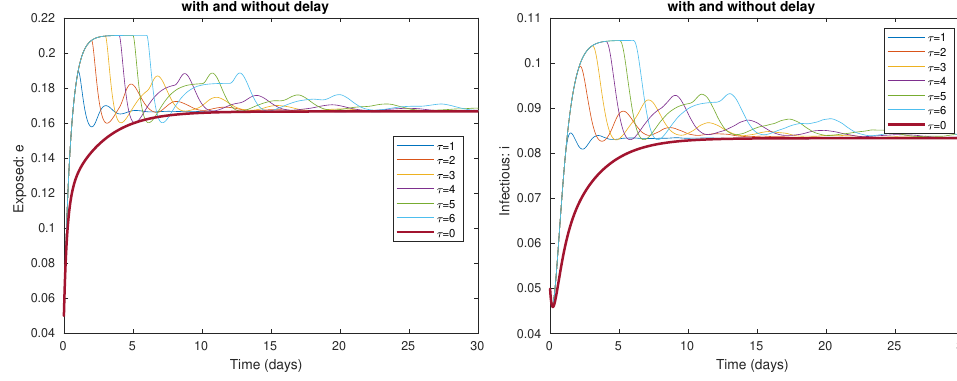
Figure 2. Dynamics of model (3) with τ ∈ [ 0,6 ] days. Parameter values as in Table 1. Table 2. Parameter values used in the simulations of Section 4.2, modeling the spread of the epidemic of COVID-19 in Italy for the period of three months starting 18 October